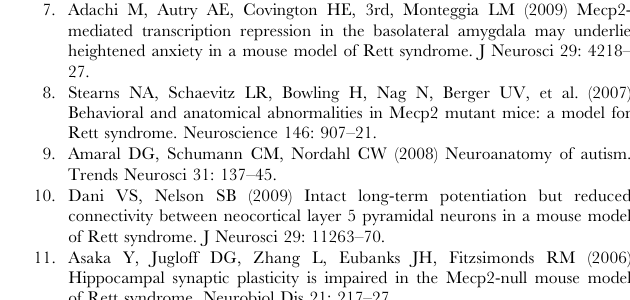
Figure S4 Effect of AC activation onto adult Mecp2X/Y and Mecp2308/Y Cortico-LA synapses. A: A 10 minute application of the AC activator Forskolin (FSK, 50 m M) potentiates the Cortico- LA EPSC in young WT animals. B: The same protocol is inefficient in adult WT mice (B1) and Mecp2308/Y mice (B2). C: Summary plot of similar pharmacological experiments in WT and KO mice. ***: P , 0.001. Number of recorded cells is indicated. Found at: doi:10.1371/journal.pone.0011399.s005 (0.21 MB TIF)